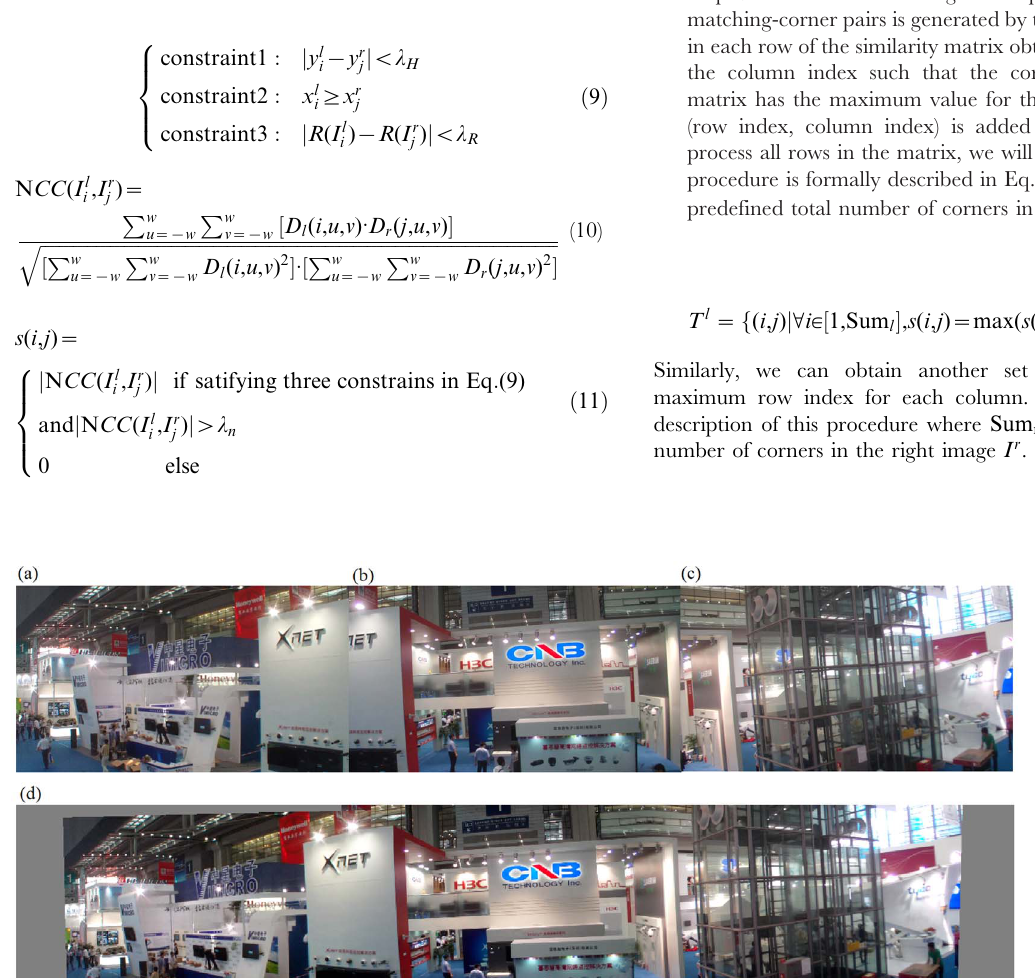
Figure 8. Experiments on the entire image-stitching algorithm (I): (a) Video image 1; (b) Video image 2 (reference image); (c) Video image 3; (d) Generated video panoramic image.